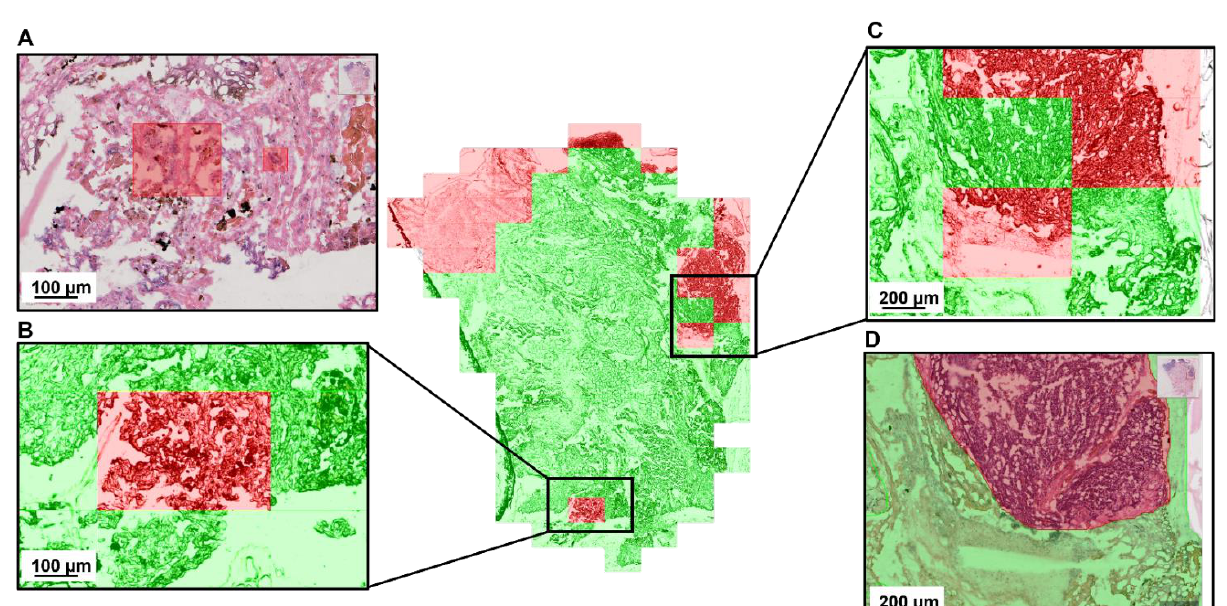
Figure 4. Detailed evaluation of the 3d CNN-based tumor classification with a false positive ( B ) and a false negative ( C ) sample. Both regions were given to a pathologist for reevaluation. The annotation ( D ) was confirmed by the second pathologist. The red regions in ( A ) mark features that the second pathologist labelled as ambiguous.